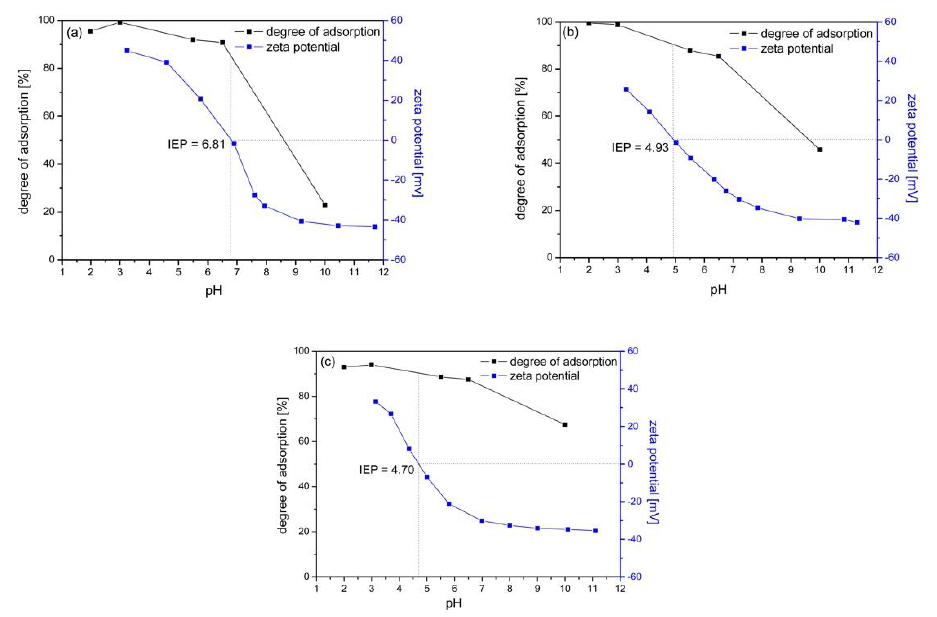
Figure 4. The degree of arsenic adsorption and the zeta potential on pure magnetite vs. the pH value, ( a ) magnetite (Fe 3 O 4 ), ( b ) magnetite modified with glucose (Fe 3 O 4 / C), and ( c ) magnetite modified with ( a ) magnetite (Fe 3 O 4 ), ( b ) magnetite modified with glucose (Fe 3 O 4 /C), and ( c ) magnetite modified with glucose and titanium dioxide (Fe 3 O 4 / C / TiO 2 ). The initial concentration of As(V) was 10 mg / glucose and titanium dioxide (Fe 3 O 4 /C/TiO 2 ). The initial concentration of As(V) was 10 mg/L.